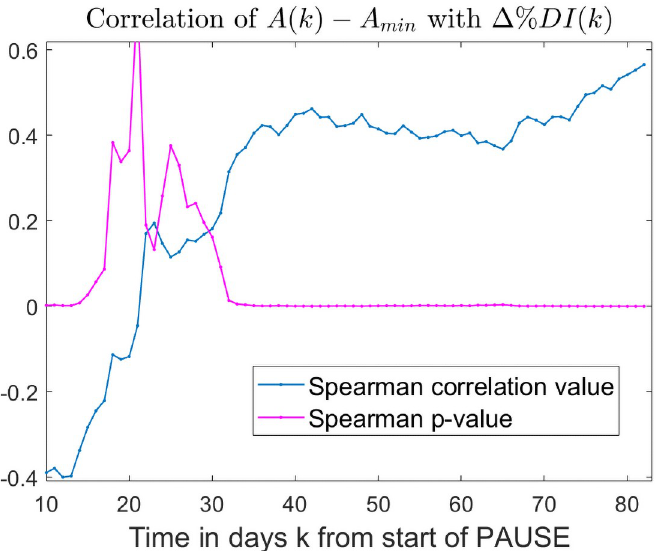
Fig 9. Correlations between traffic comeback and epidemic recovery after the start of PAUSE. For each day k � 10 after the start of PAUSE (represented along the horizontal axis), we computed the correlation between the comeback in driving from the lowest level after PAUSE A ( k ) − A min and Δ % DI . Both measures were calculated for the 7-day window smoothed respective time series. The Spearman correlation values are shown in blue, and the p-values in purple